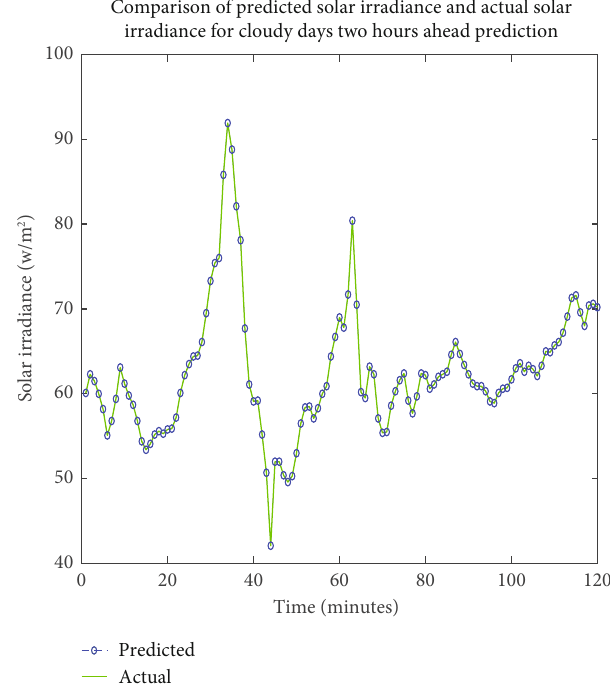
Figure 25: Comparison of predicted solar irradiance and actual solar irradiance for cloudy day two-hour-ahead prediction.